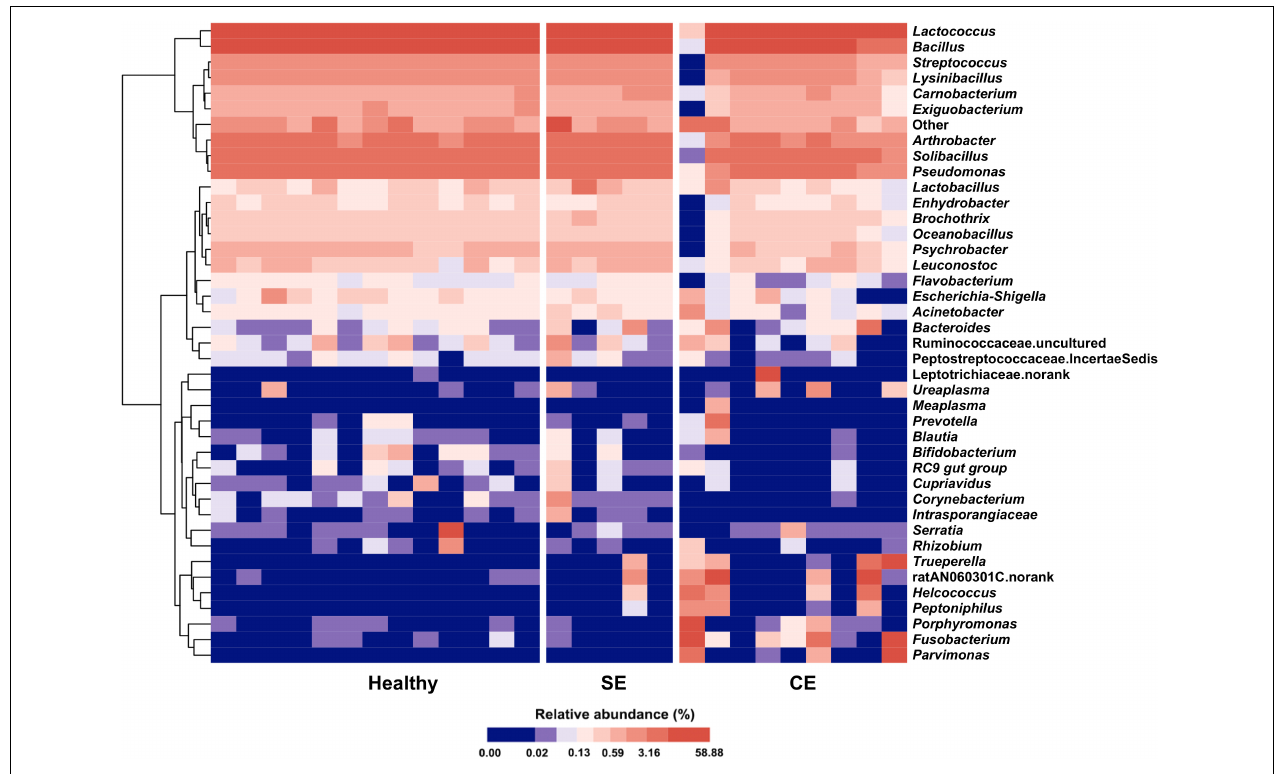
FIGURE 2 | Heat map with average linkage clustering based on Bray–Curtis distance showing the relative abundances of the top 40 genera in each cow. The relative abundance of each genus is indicated by a gradient of color from blue (low abundance) to red (high abundance). Healthy, healthy cows, n = 13; SE, subclinical endometritic cows, n = 5; CE, clinical endometritic cows, n = 9.